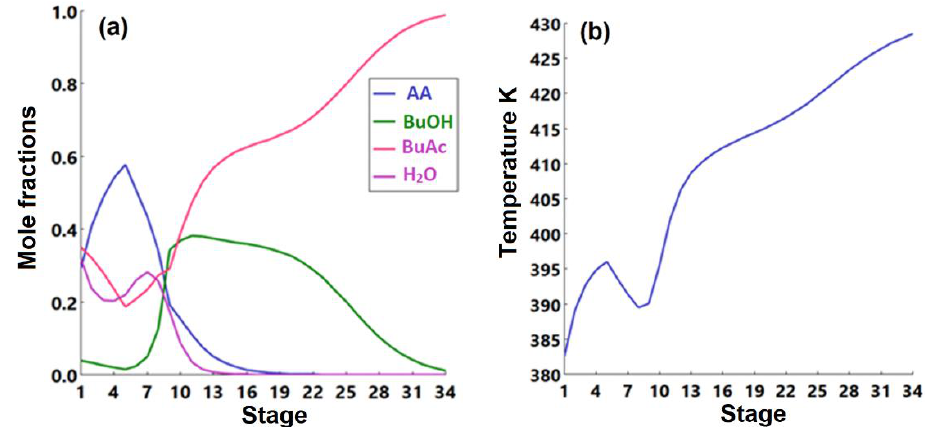
Figure 17. ( a ) The liquid-phase molar compositions of components as a function of stage number. ( b ) Temperature profile inside the reactive distillation column as a function of stage number.